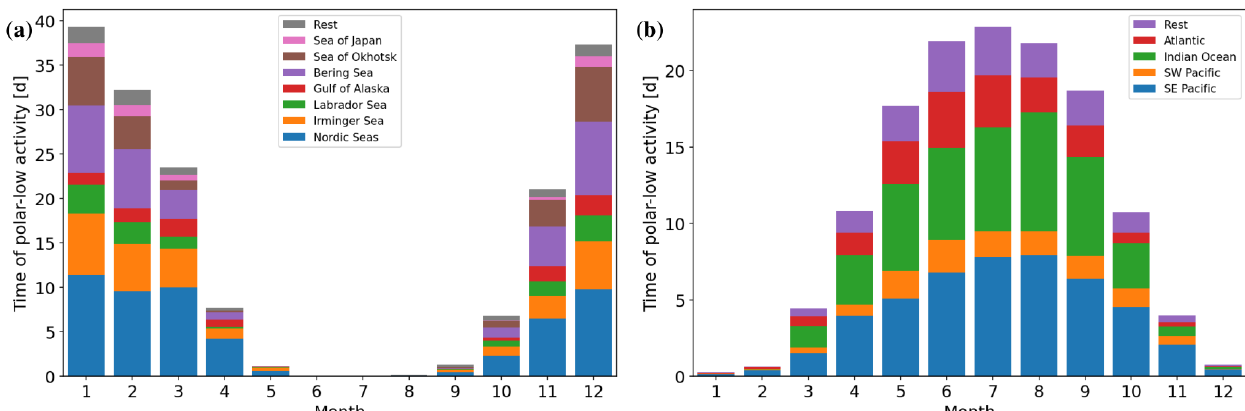
Figure 4. The average monthly time of polar-low activity normalized to months with a duration of 30d for (a) the Northern Hemisphere and (b) the Southern Hemisphere. Given the typical polar-low lifetime of around 24h, 1d of activity represents approximately one polar low. Colours denote the contribution of specific regions marked by boxes in Fig. 3.